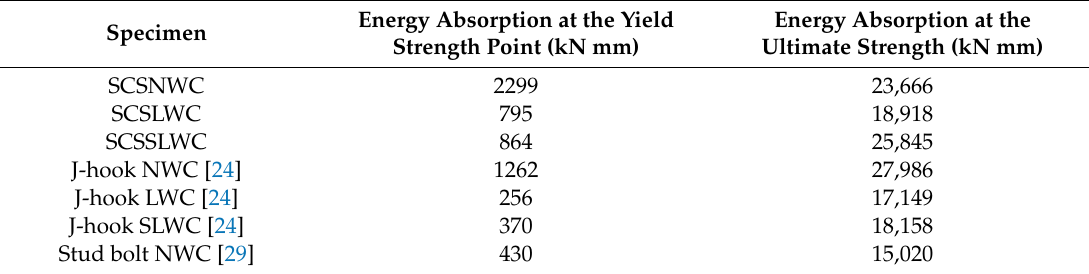
Figure 20. Energy absorption of specimens ( a ) at the yield strength point and ( b ) at the ultimate strength. Table 9. Energy absorption of the